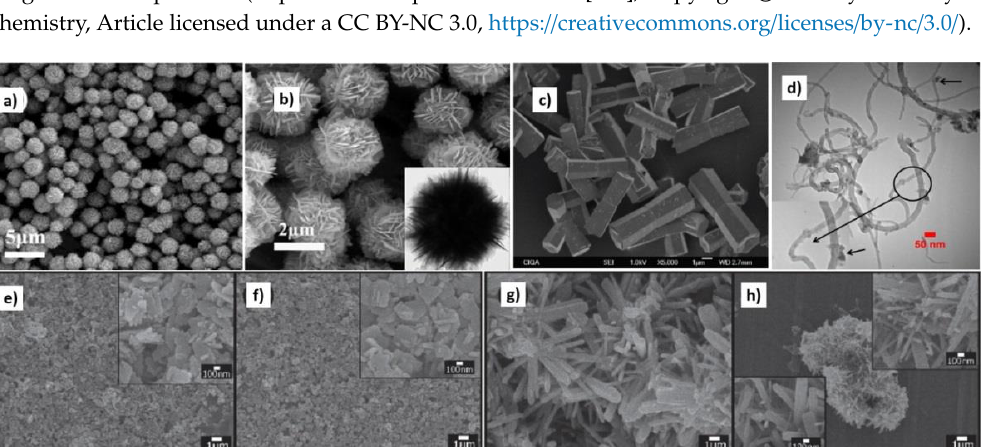
( a ) SEM image of ZnO hexagonal columns; ( b ) SEM image of ZnO cauliflower-like morphology. (( a , b )